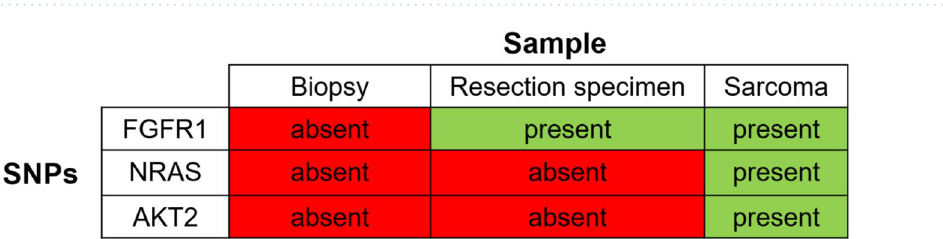
Figure 4. Summary of SNPs found in the different tissue samples (Case 3). SNPs in the resection: FGFR1 (chromosome 8; position (GRCh37) 38287303; c354G > A; p.E118). SNPs in the pleomorphic sarcoma: FGFR1 (chromosome 8; position (GRCh37) 38287303; c354G > A; p.E118); AKT2 (chromosome 19; position (GRCh37) 40742052); NRAS (chromosome 1; position (GRCh37)